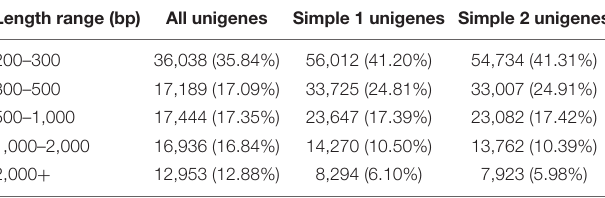
TABLE 1 | Sequential assembly results.